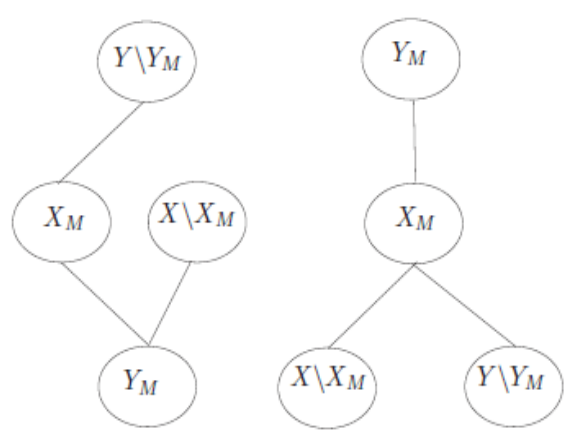
Figure 1. Networks ℵ (cid:48) and ℵ (cid:48)(cid:48)